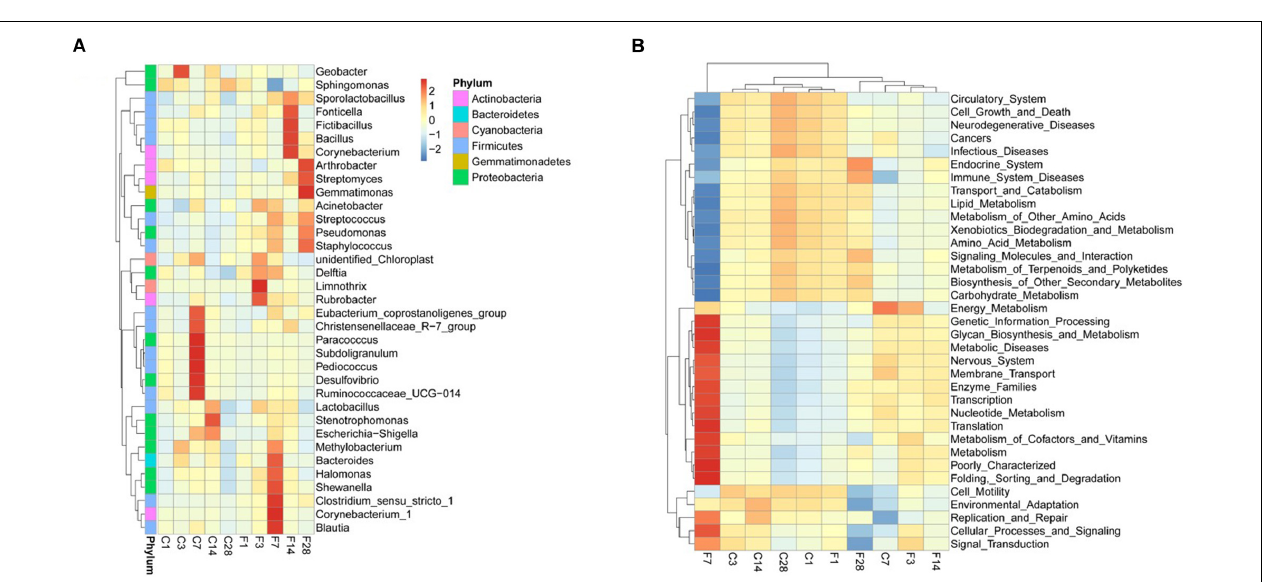
FIGURE 6 | Composition and genomic function of LRT microbiota after influenza virus infection showing cluster heat maps of (A) species abundance at the genus level and (B) genomic function (C, the group treated with saline; F, the group treated with influenza virus; the number followed C/F represented the day post inoculation. n = 5 or 6 per